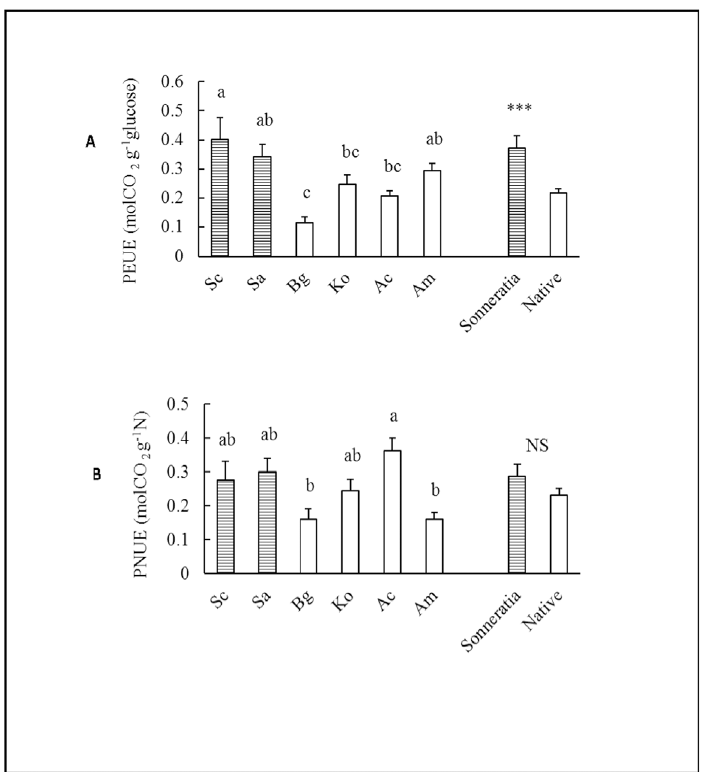
Fig 5. Comparisons of the annual average (A) PEUE and (B) PNUE between alien Sonneratia and native mangrove species. Fig 5 legend: Error bars represent 1 SE. Different letters indicate significant differences at p (cid:6) 0.05 among the six species according to two-way ANOVA; *** indicates a significant difference between alien Sonneratia and native mangrove species at p (cid:6) 0.001, and NS indicates not significant at p (cid:6) 0.05 according to the independent samples